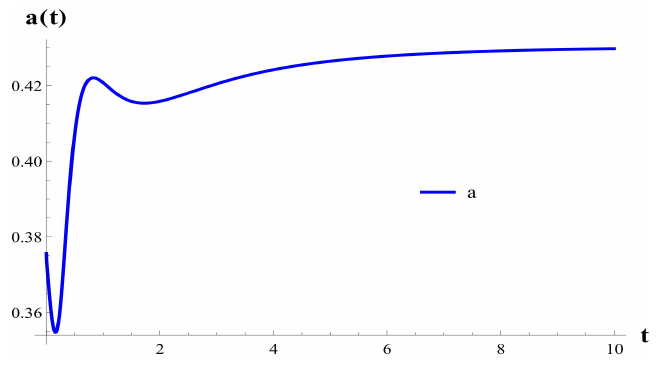
Figure 5. Time dependence of the scale factor a ( t )